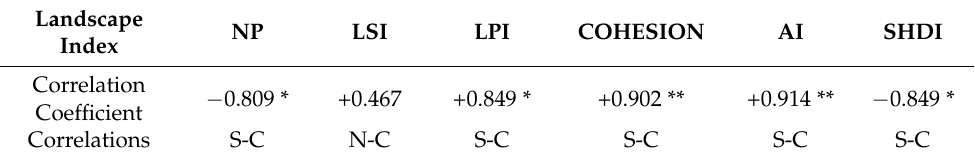
Table 5. Correlation between the total ESV and landscape pattern